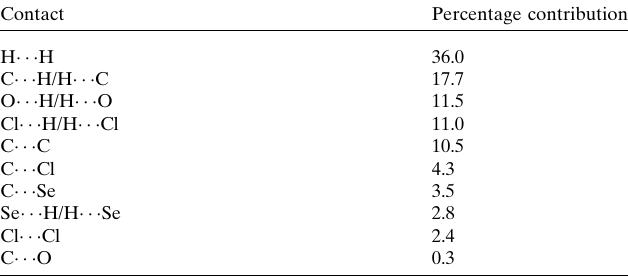
Table 2 Relative percentage contributions of the close contacts to the Hirshfeld surface of the title